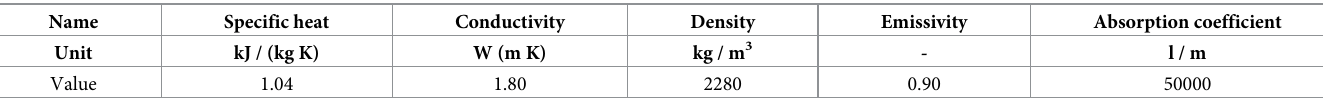
Table 1. Thermal properties of